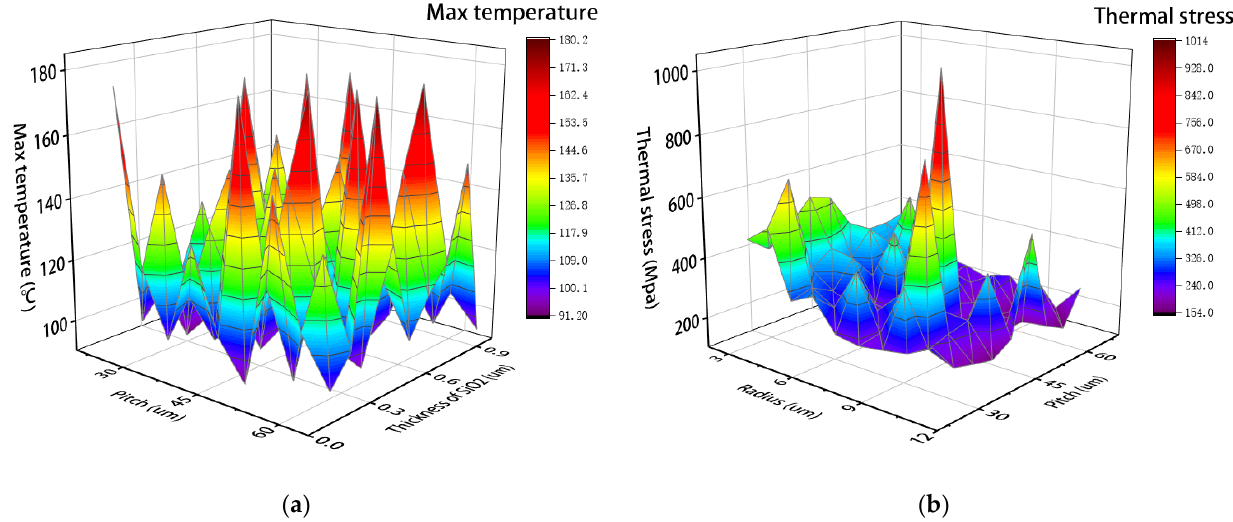
Figure 5. Diagram of performance variation with structural parameters: ( a ) Effect of parameters on peak temperature of TSV; ( b ) Effect of parameters on stress of TSV.